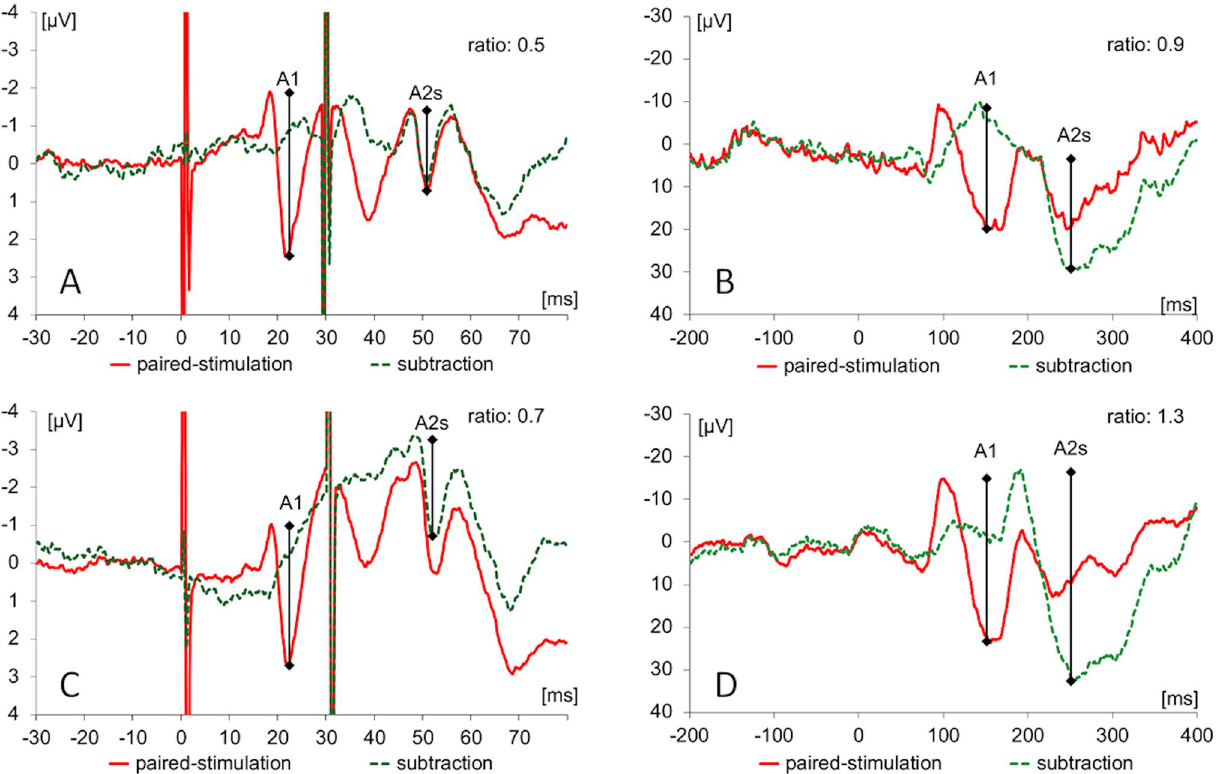
Figure 6. Paired SEP and VEP traces from one subjects. Shown are SEPs ( A , C ) and VEPs ( B , D ) recorded at lowest ( A , B ) and highest levels ( C , D ) of estradiol. Original traces obtained during paired stimulation are shown in red, while the dotted green traces result from subtracting the single-stimulation trace from the paired- stimulation trace (cf. Figure 1). The response amplitudes of the first response (A1) and the second response after subtraction (A2s) and the resulting paired-stimulation ratios are shown.